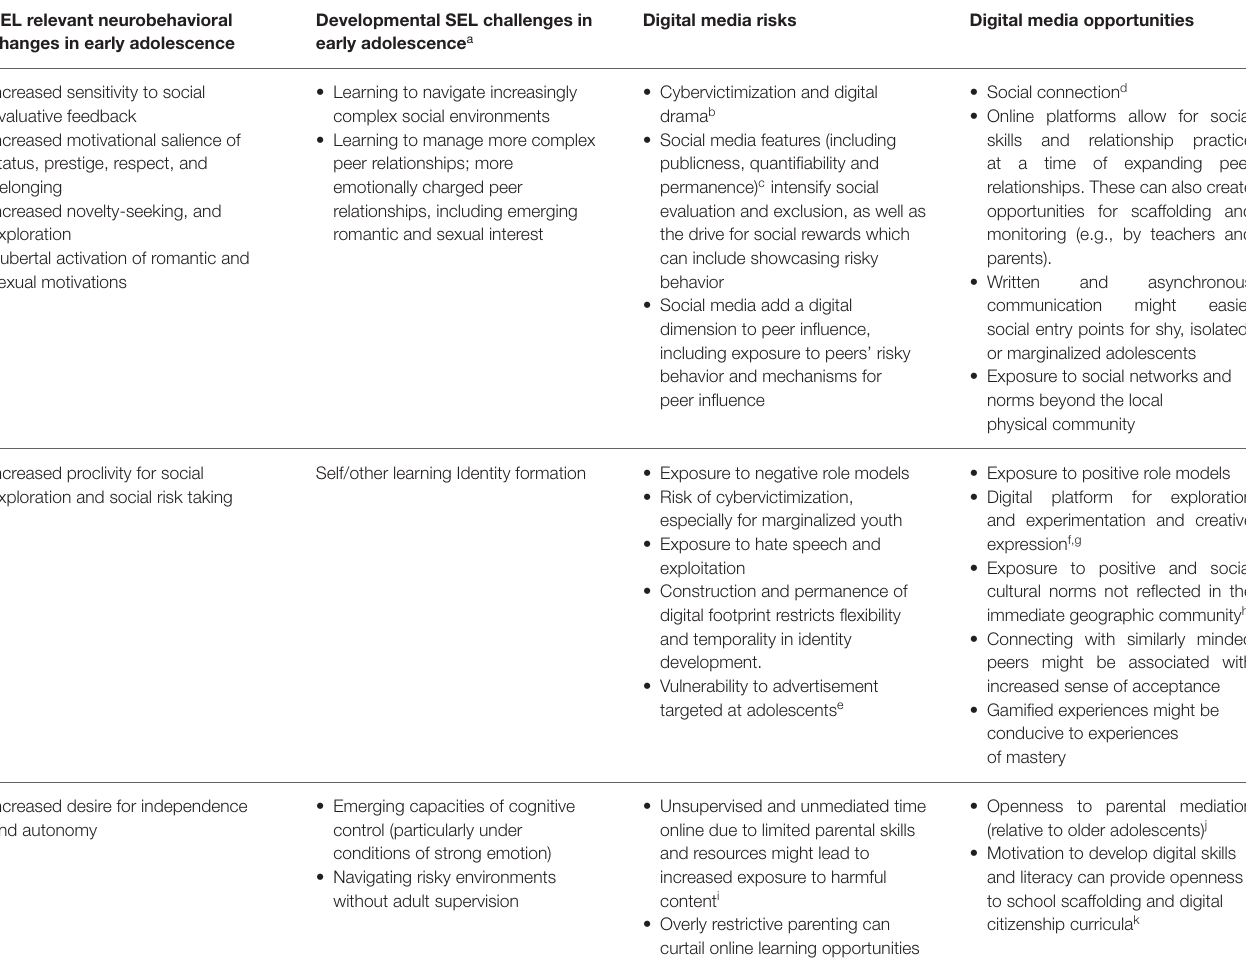
TABLE 2A | Examples of how specific aspects of social emotional learning & identity development in early adolescence create risks and/or